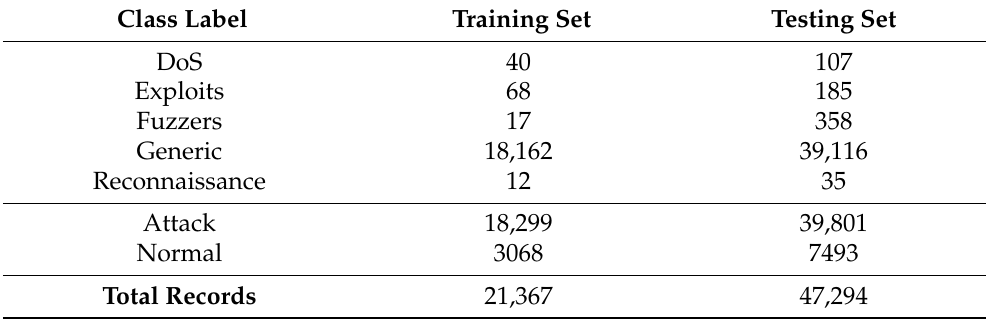
Table 3. # of instances of DNS records from UNSW-NB15.